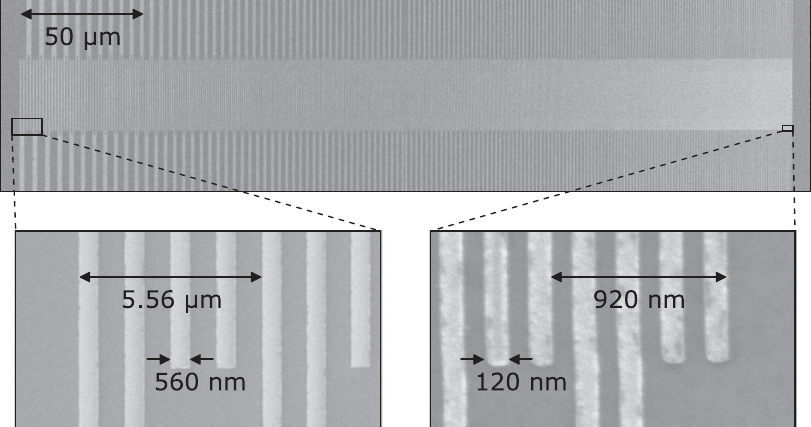
simulation.FIG. 2. SEM images of the chirp IDT with zooms (insets) in the regions of large (left panel) and small (right panel) periodicity of the interlocked electrodes.